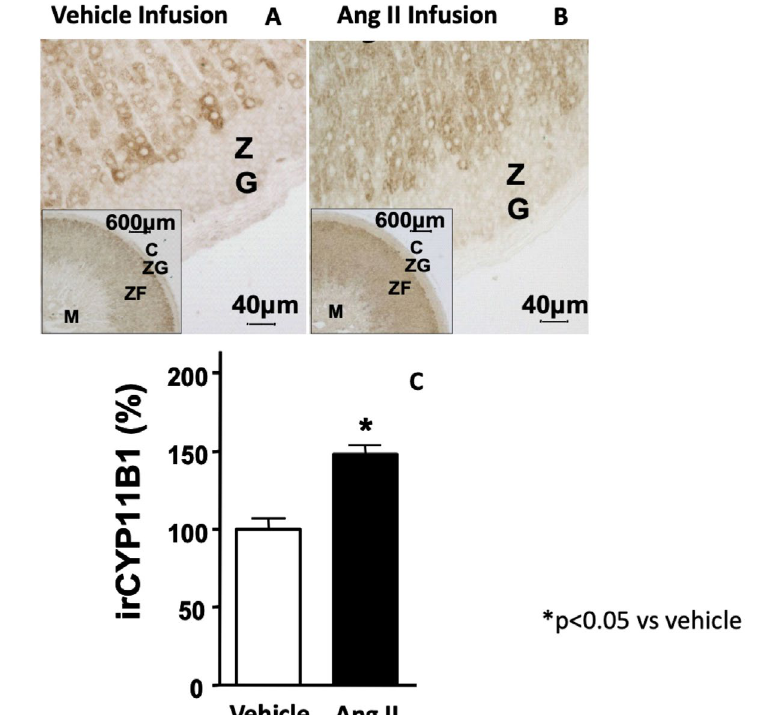
Figure 3. 11-β hydroxylase immunostaining of rat adrenal cortex after the treatment with vehicle (Panel A) and Ang II (700 μg/ kg·day) for 1-week (Panel B). Quantitative analysis of immunostaining showed a significant increase of the 11-β hydroxylase protein expression after Ang II treatment as compared to vehicle (Panel C) Note. Adapted with permission from “Expression and functional role of urotensin-II and its receptor in the adrenal cortex and medulla: novel insights for the pathophysiology of primary aldosteronism.” Giuliani L, Lenzini L, Antonello M, Aldighieri E, Belloni AS, Fassina A, et al. J Clin Endocrinol Metab. 2009;94:684-90. (https://doi.org/10.1210/jc.2008-1131 ). © Oxford University